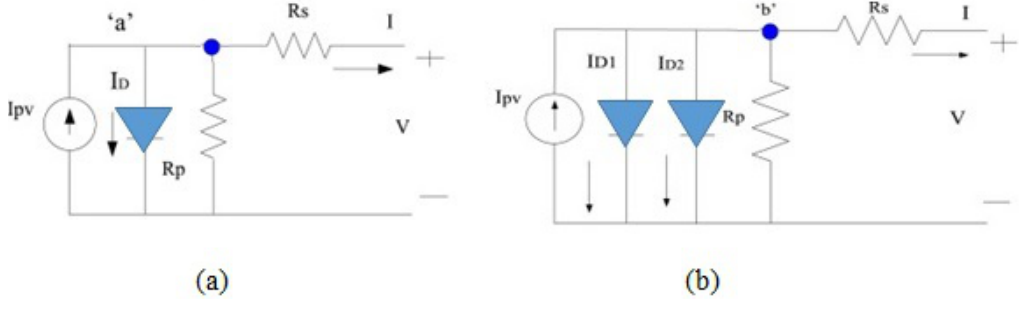
Figure 3. ( a ) Single diode model ( b ) Double diode